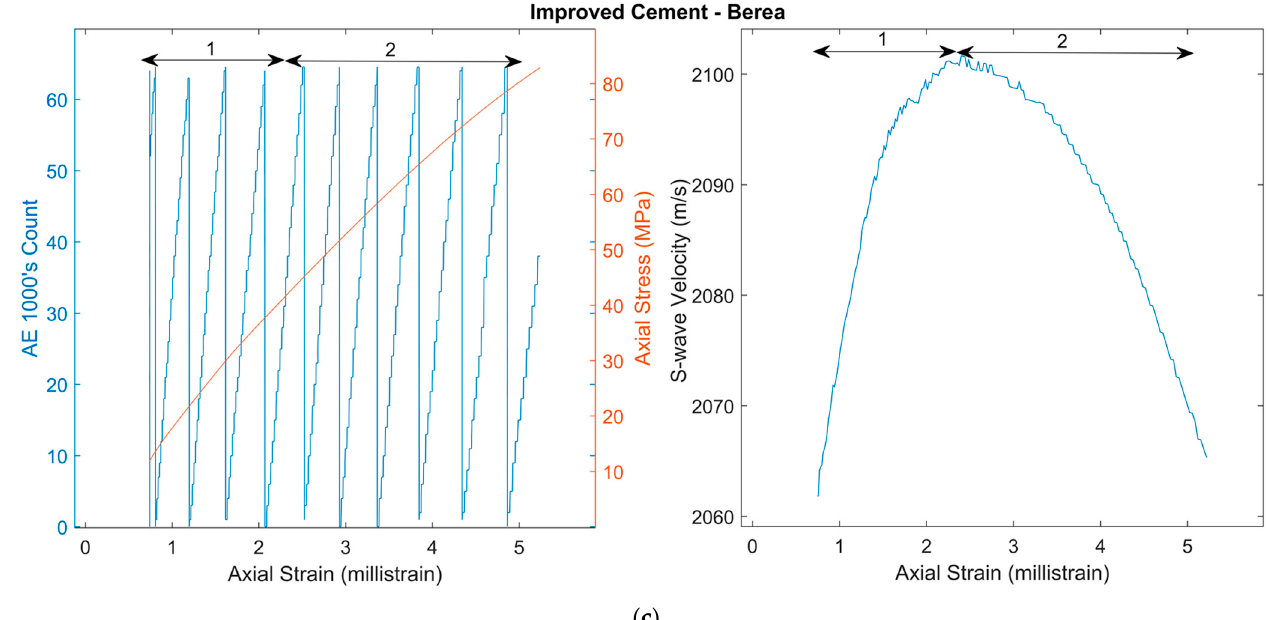
Figure 6. Failure analysis in a composite specimen. Acoustic emission (AE) counts in blue and axial stress in red are shown as a function of axial strain for ( a ) cement–Berea, ( b ) cement–Torrey, and ( c ) improved cement–Berea composite specimen in the left plots. The fracture mechanism is a combination of features observed in both cement and sandstone. The right plots show the S-wave velocities as a function of axial strain.